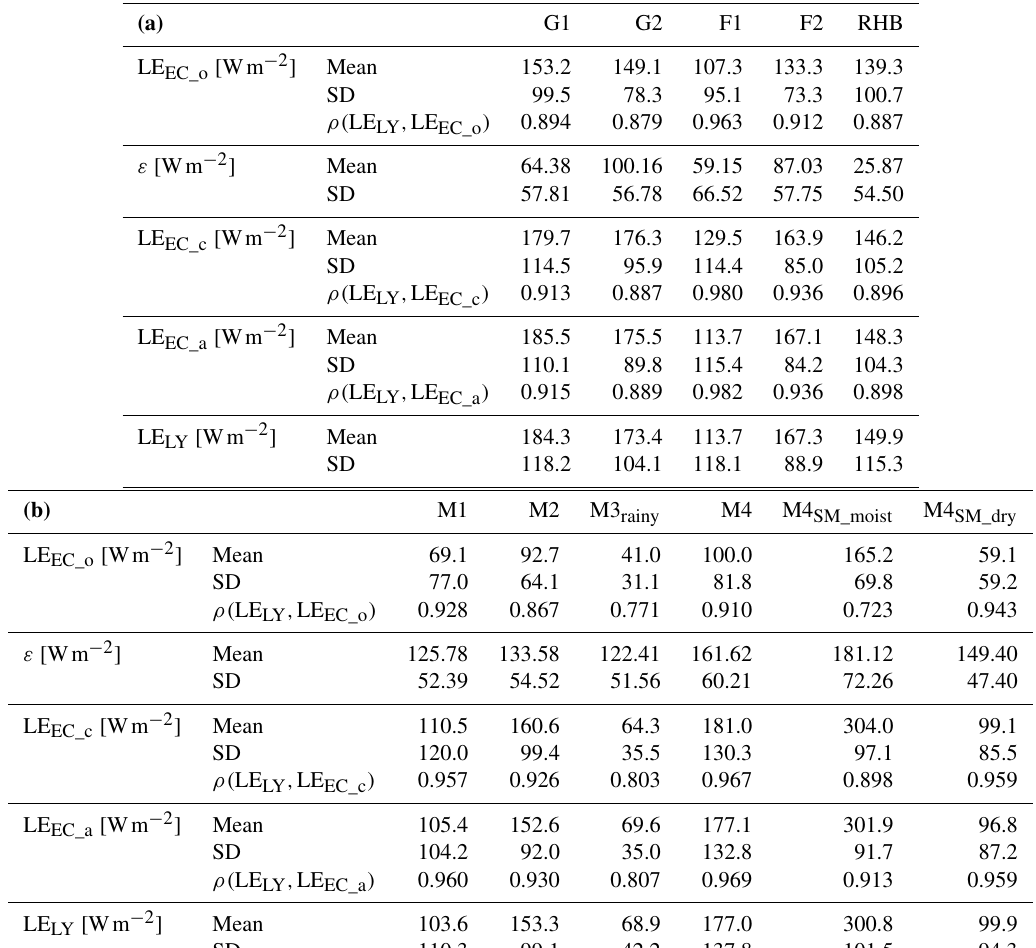
Table 2. (a) Basic evaporation characteristics for the humid stations ( ρ = correlation coefficient). (b) Basic evaporation characteristics for the Majadas stations ( ρ = correlation